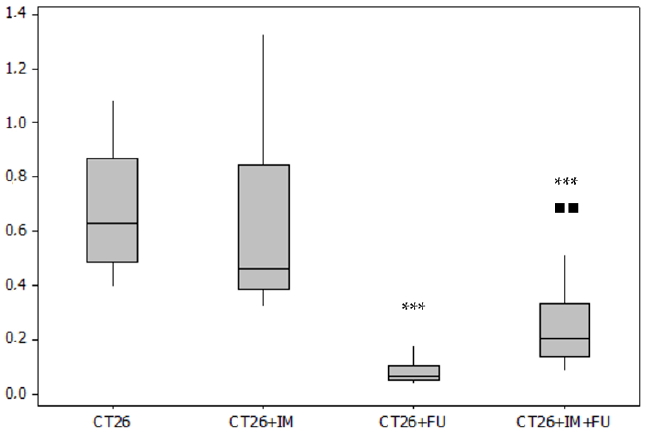
Figure 1. The effect of treatments on tumour weight. CT26-tumour control ( n = 10); CT26 + IM-CT26 treated with IM ( n = 10); CT26 + 5-FU-CT26 treated with 5-FU ( n = 10); CT26 + IM + 5-FU-CT26 treated with IM and 5-FU ( n = 10). *** p < 0.001 vs. CT26 group, ■■ p < 0.01 vs. CT26 + 5-FU.